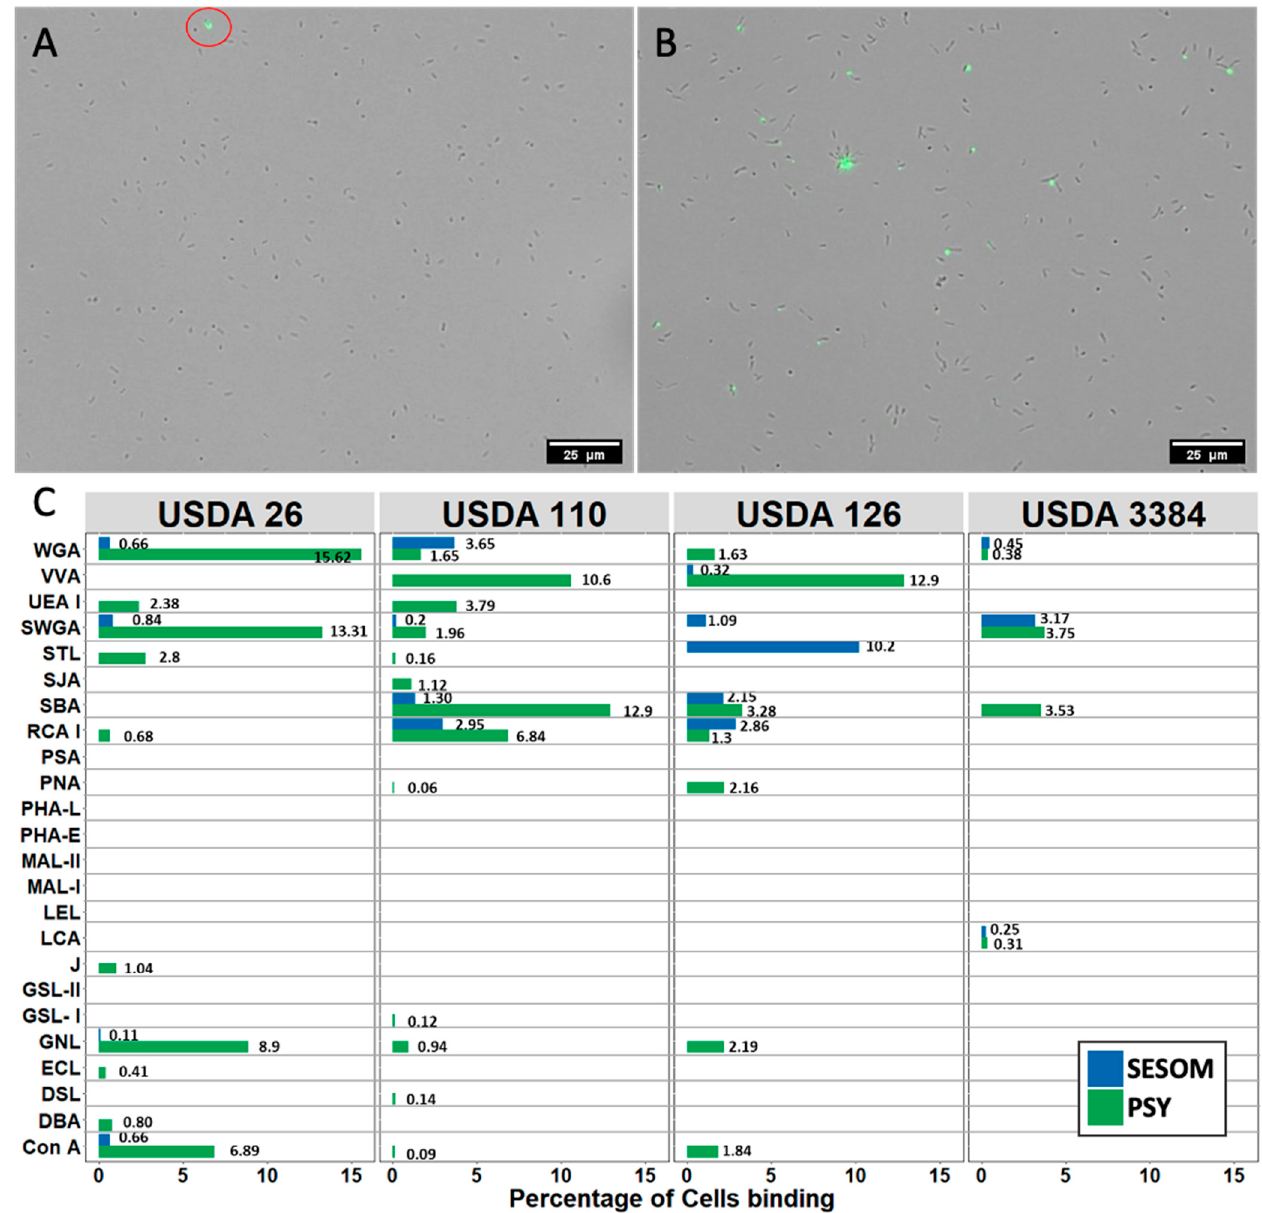
Figure 4. Lectin binds only to a subset of cells in the population. Binding of sWGA to B diazoefficiens USDA 26 grown in SESOM ( A ) and PSY ( B ), and the percentage of cells binding to the 25 lectins after culturing in PSY and SESOM ( C ).